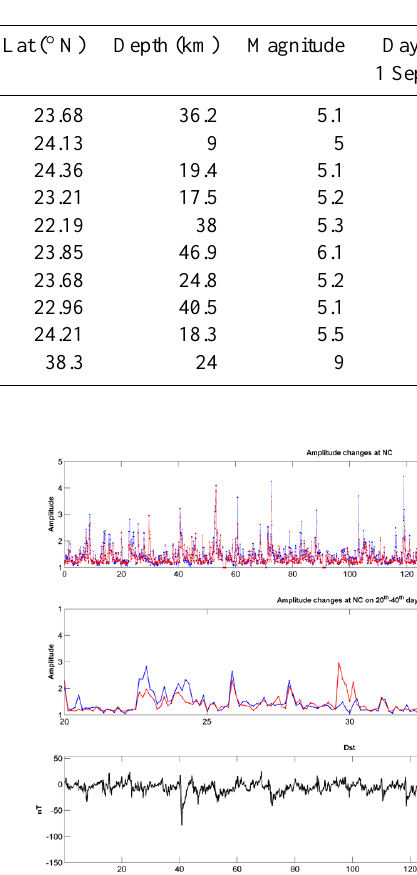
Table 2. Earthquakes retrieved from the catalog of Central Weather Bureau (http://www.cwb.gov.tw) in relation to this study.